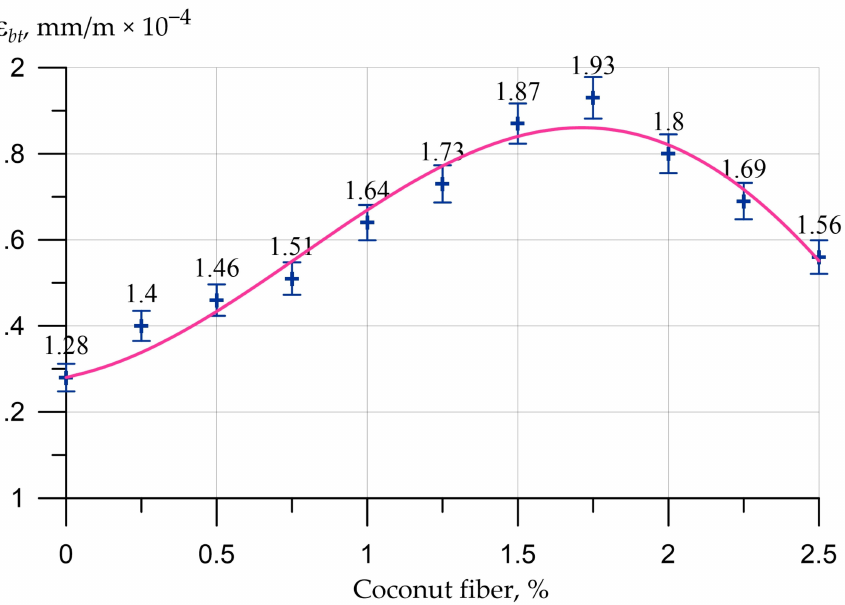
Figure 12. Dependence of the limiting deformations in axial tension ( ε bt ) of prism concrete samples with dimensions of 100 × 100 × 400 (mm) on the percentage of dispersed reinforcement with coconut